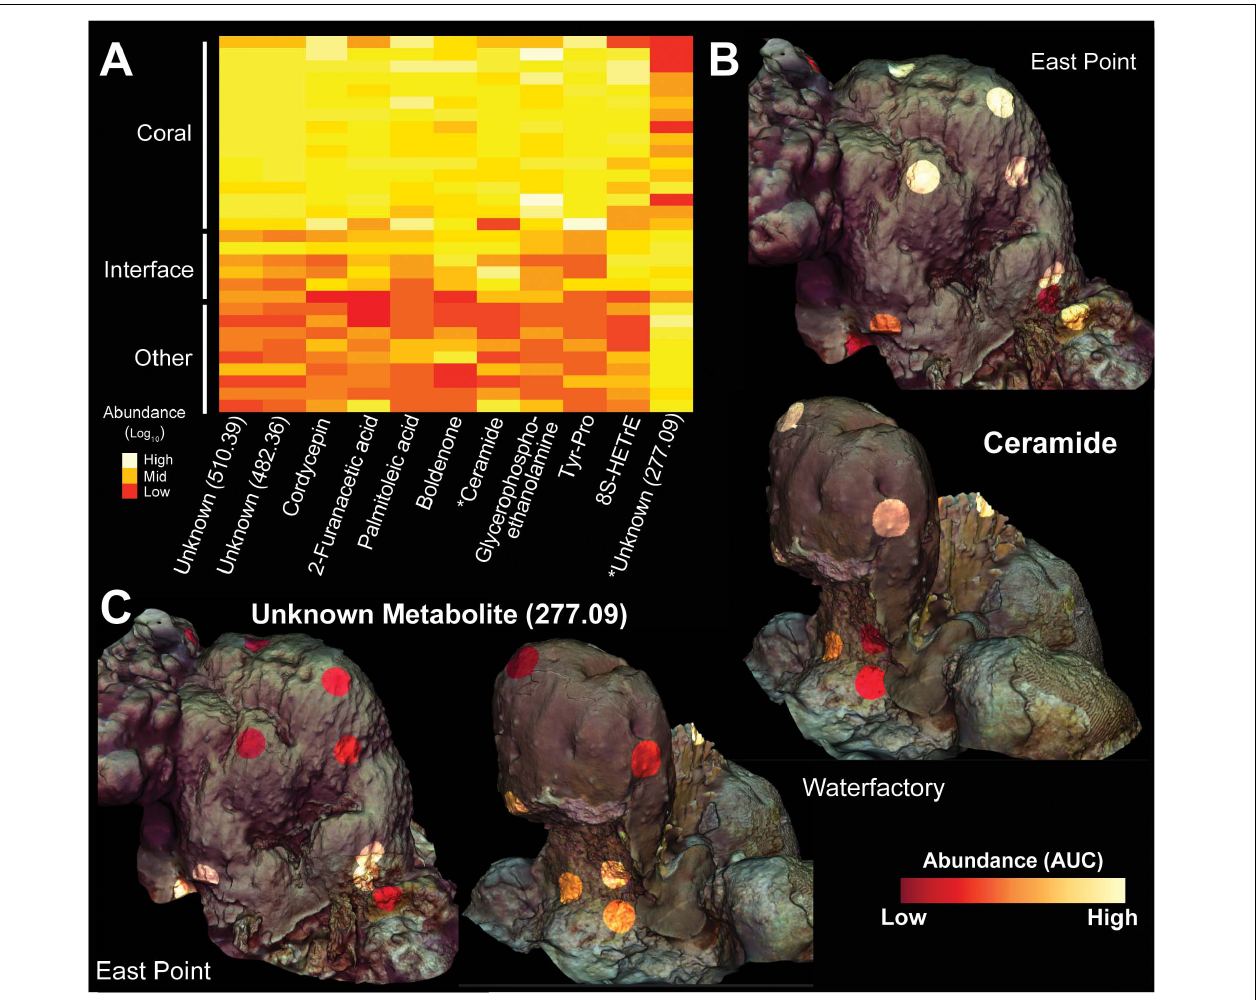
FIGURE 8 | Heatmap and 3D cartography of metabolites from Orbicella faveolata colonies, competitors and interfaces. (A) Heatmap of metabolites selected from the supervised random forests analysis. Mass to charge ratios are shown for unknown metabolites. Abundances (Area Under the Curve/AUC) are log-transformed and colors are normalized to columns with red representing the lowest abundance and white representing the highest. Asterisks highlight metabolites shown in the 3D models. 3D coral models mapped with the abundances of (B) ceramide and (C) an unknown metabolite (277.09) from both sampling sites. Ceramide abundance ranges from 0-124,247 AUC at East Point and 0-69,148 AUC at Water Factory. For the unknown metabolite (277.09), the abundance ranges from 0-338,137 AUC at East Point and 0-137,151 AUC at Water